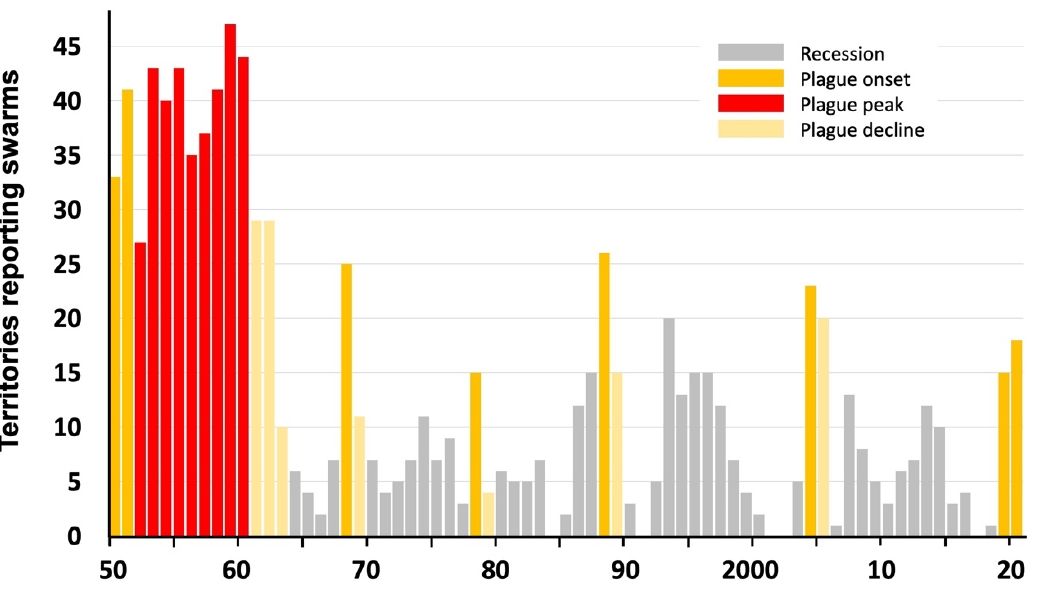
Figure 1. The number of countries in which desert locusts were detected since 1950, with fewer countries having an onset of major desert locust activity (i.e., major upsurges and plagues) since 1965. Control has been achieved sufficiently early to avoid a major plague, but in 2019/20 the locusts spread without early detection (updated from [5,6]).